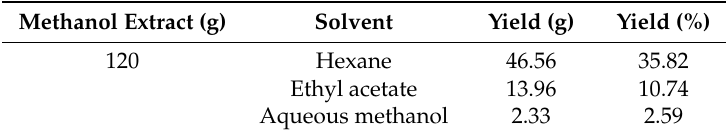
Table 4. Liquid–liquid partition of P. cubeba L. methanol